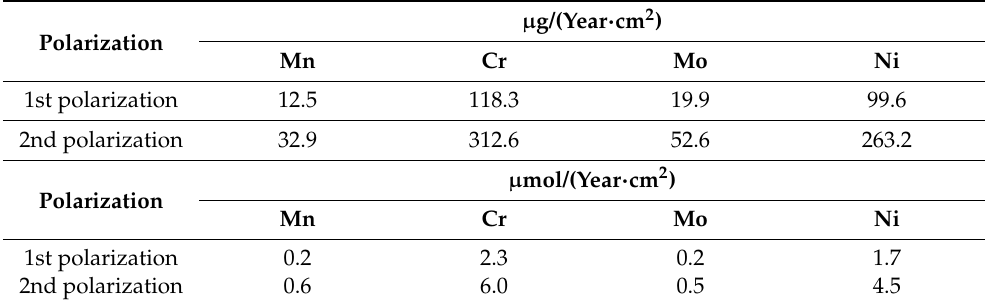
Table 5. Theoretical mass and amount of ions released from 1 cm 2 during the 1-year exposition.